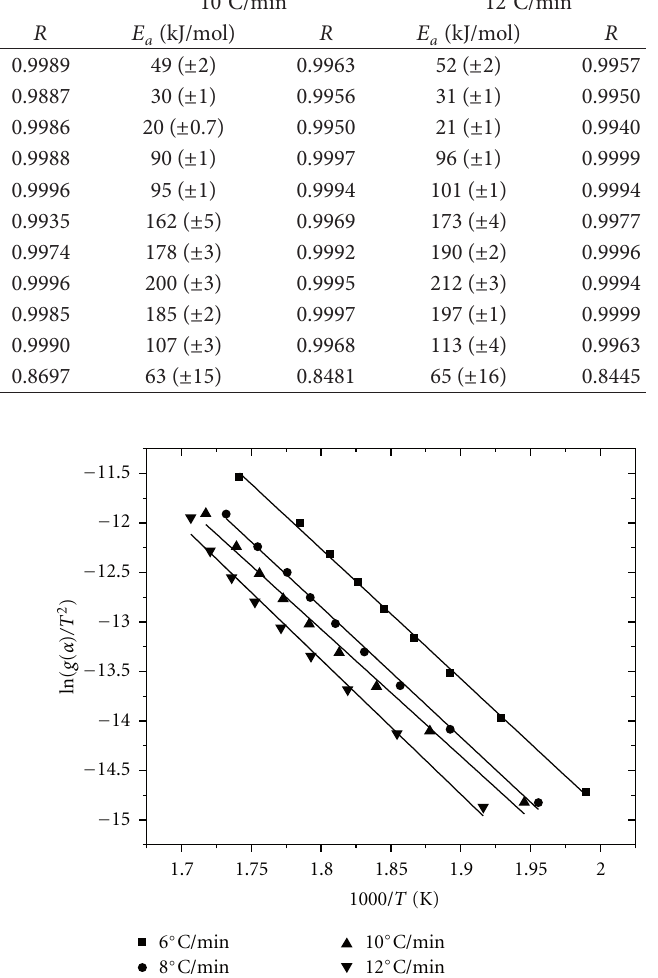
T 3: Activation energies obtained using the Redfern-Coats method for several solid state processes at the heating rates of 6, 8, 10, and C/min for Zr(tmhd) . 12 4 ∘